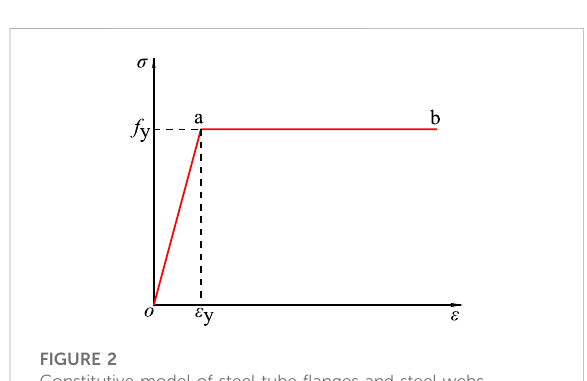
FIGURE 2 Constitutive model of steel tube fl anges and steel webs.